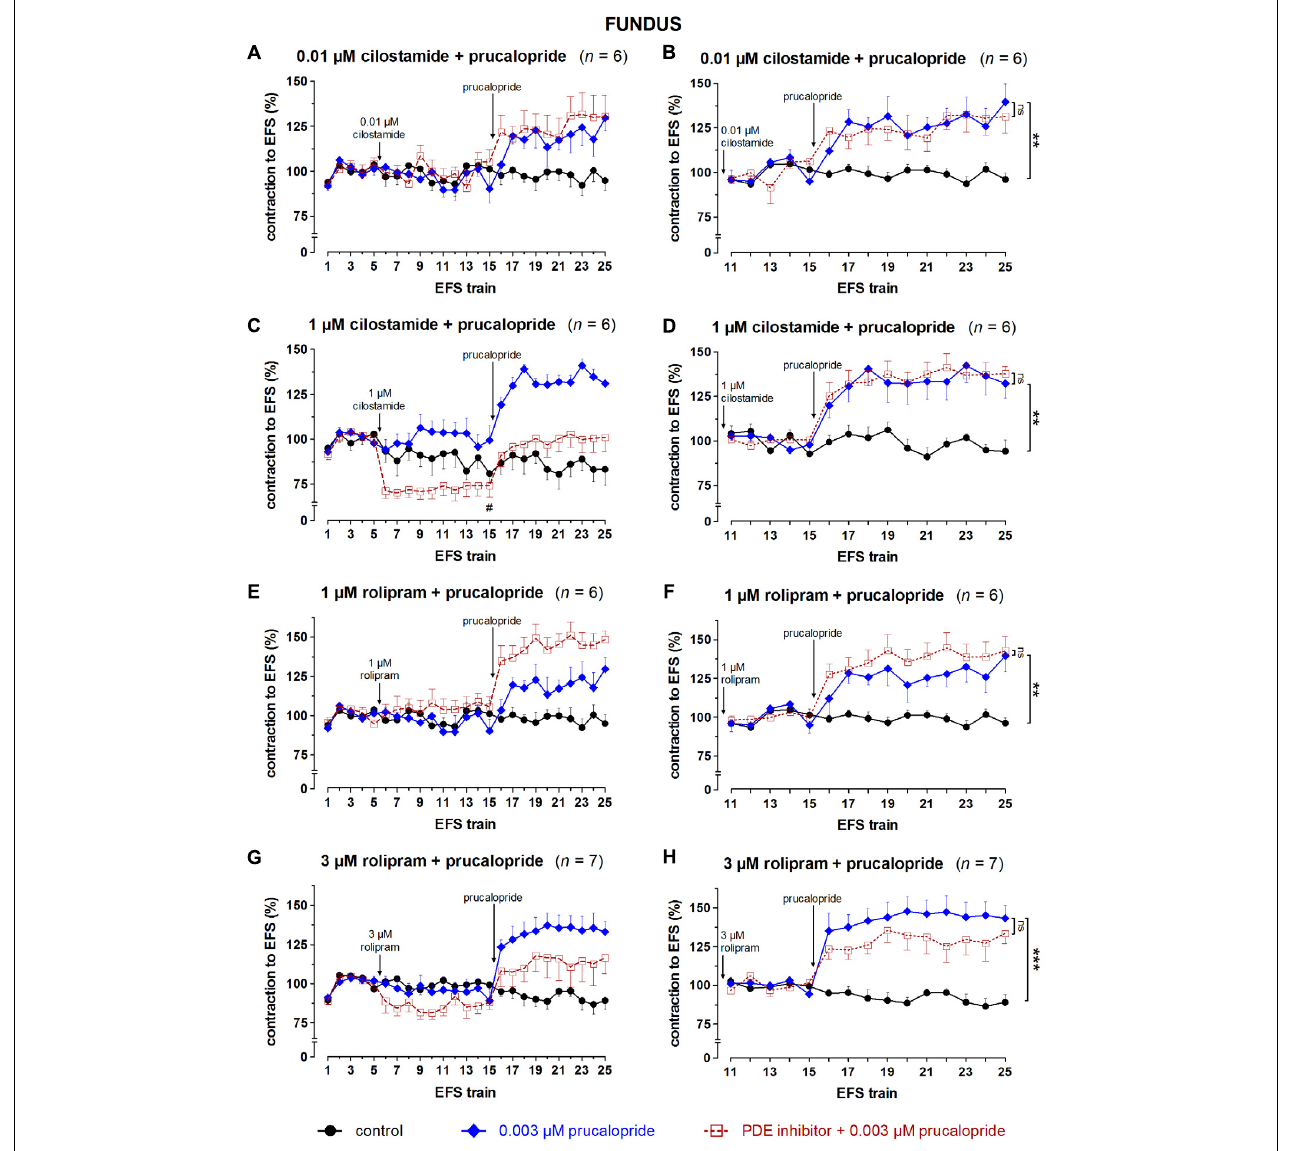
FIGURE 10 | Influence of 0.01 (A,B) and 1 (C,D) µ M cilostamide, 1 (E,F) and 3 (G,H) µ M rolipram on the facilitating effect of 0.003 µ M prucalopride on submaximal electrically induced cholinergic contractions at V 50% (10 s trains at 4 Hz, 0.5 ms, interval of 5 min) in murine fundus circular smooth muscle strips. The number of the consecutive stimulation trains is given on the y-axis. Contractions are expressed as percentage of the mean of the five contractions before addition of the PDE inhibitor (trains 1–5; A,C,E,G ) or of the five contractions in the presence of the PDE inhibitor just before adding prucalopride (trains 11–15; B,D,F,H ). Experiments were performed in the continuous presence of 4 µ M guanethidine and 300 µ M L-NAME. Means ± SEM. Left panels, last EFS-induced contraction before adding prucalopride: # P < 0.05 versus prucalopride (one-way ANOVA with Bonferroni corrected t -test for two comparisons i.e., PDE inhibitor versus control and versus prucalopride). Right panels, last EFS-induced contraction: ns not significant, ∗∗ P < 0.01, ∗∗∗ P < 0.001 (one-way ANOVA with Bonferroni corrected t -test for two comparisons i.e., prucalopride versus control and versus prucalopride in the presence of the PDE